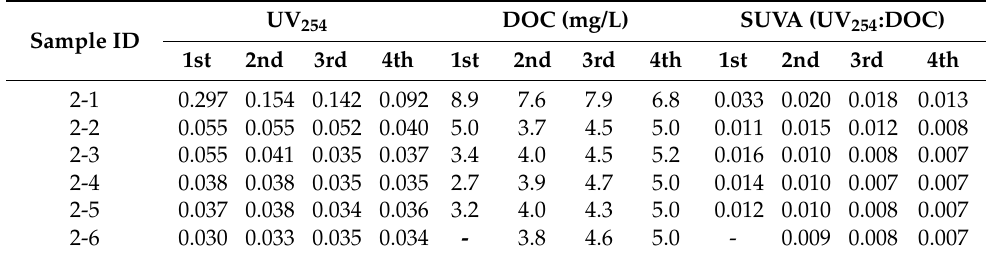
Table 4. Measurements of UV 254 , DOC, and SUVA in the waters collected in System II.